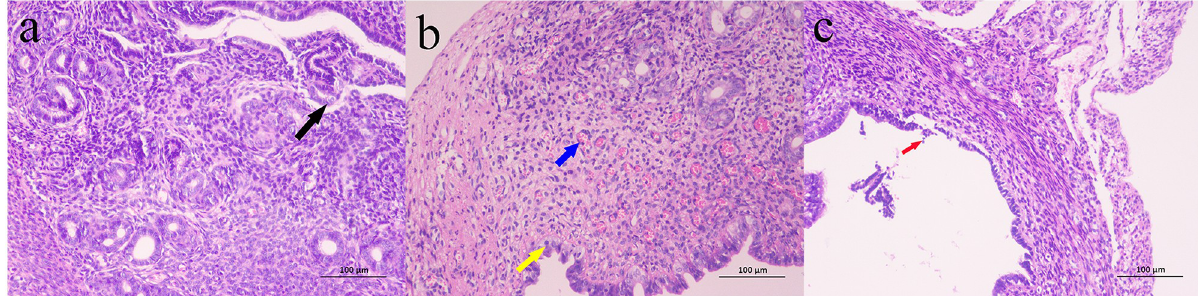
Fig 1. Effect of IOP on the histopathology of endometritis. (a). Control group. Local exfoliation of endometrial epithelial cells (black arrow). (b). LPS group. A small number of endometrial and glandular epithelial cells were swollen, the cytoplasm was loose and light stained (yellow arrow), and the lamina propria was heavily congested and dilated (blue arrow). (c). LPS+IOP Group. Local endometrial epithelium narrowed and a few endometrial epithelial cells shed (red arrow). (Hematoxylin and eosin staining, magnification 200 × ).